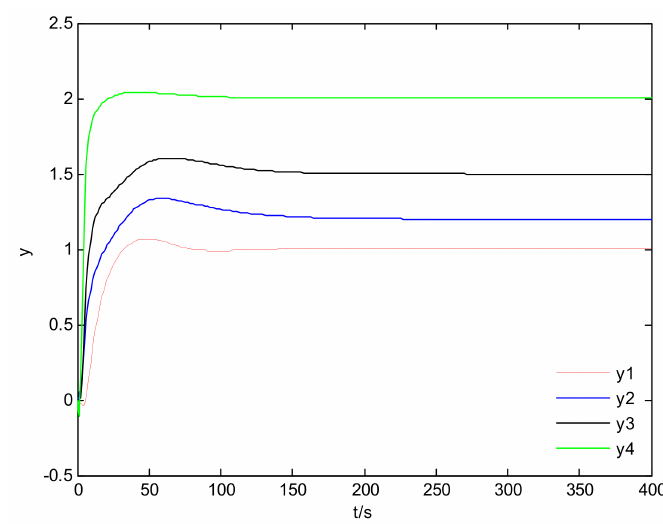
Figure 3. Output responses of the normal system.